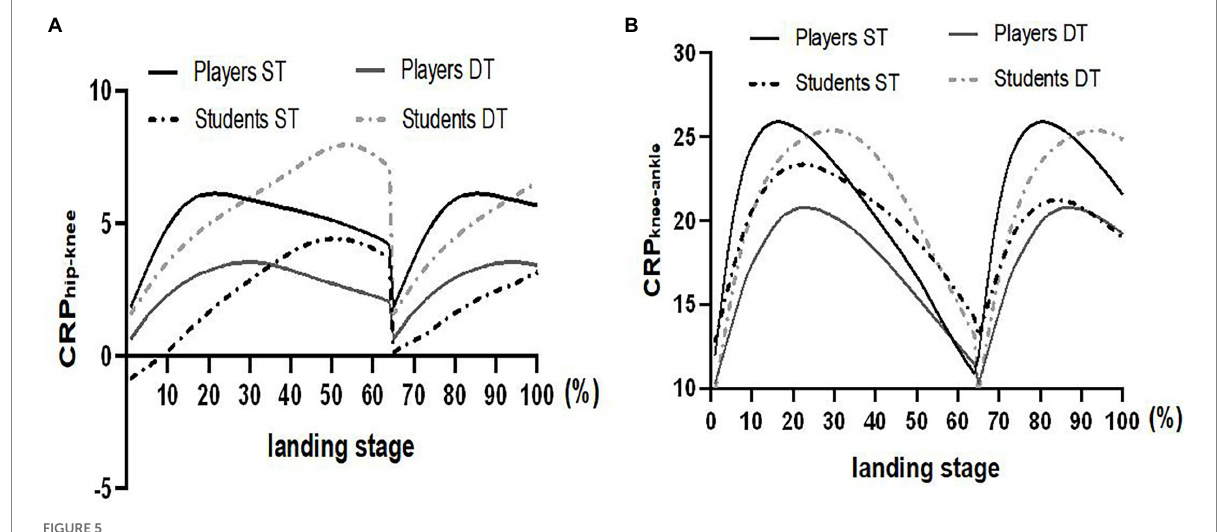
FIGURE 5 Changes in continuous relative phase (CRP) during